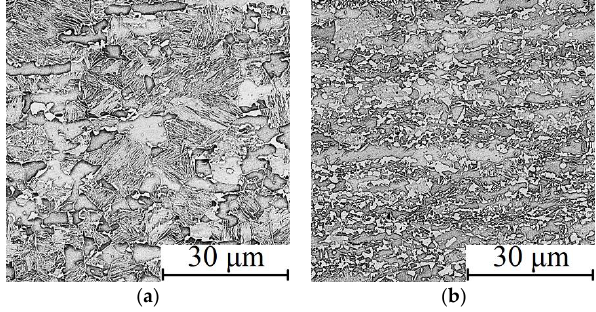
Figure 1. SEM micrographs of the ( a ) Quenching and Partitioning (Q&P) and ( b ) Transformation Induced Plasticity (TRIP) steels in as-received conditions.